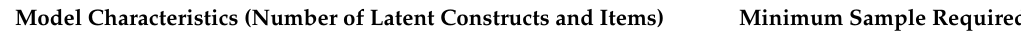
Table 2. Minimum sample size required for SEM